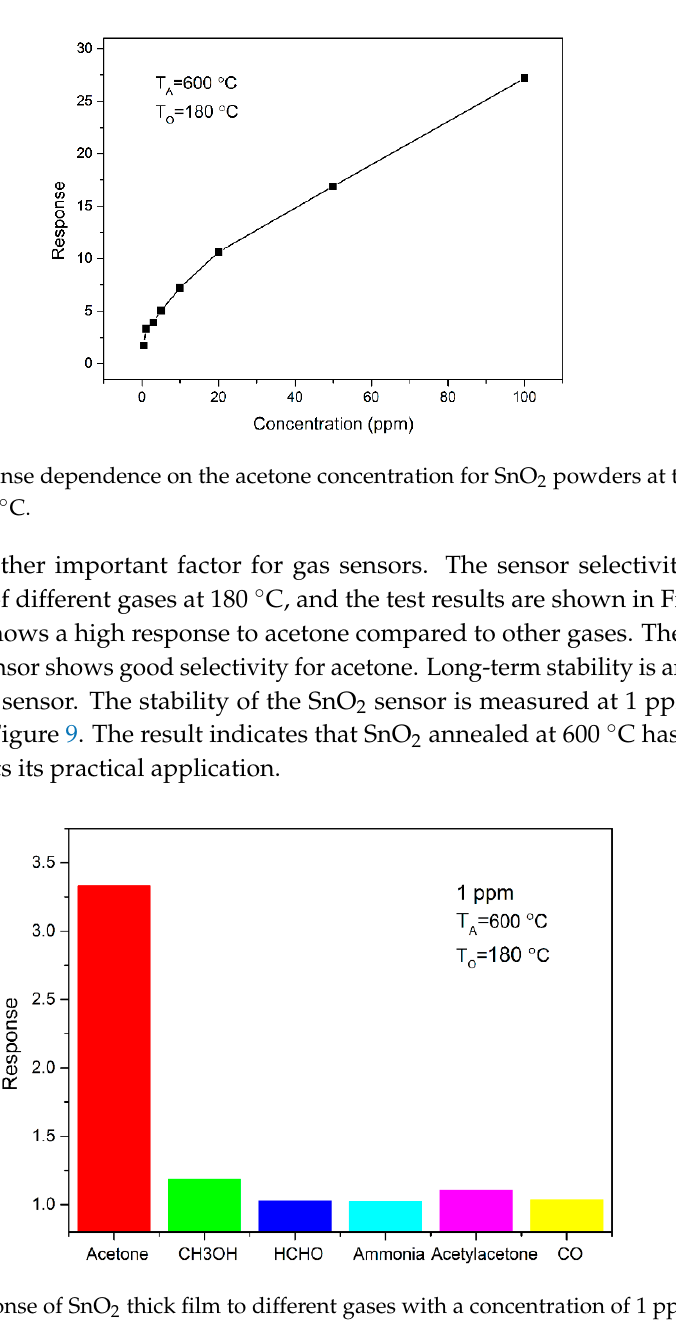
Figure 9. Response stability of SnO 2 thick film sensor measured upon exposure to 1 ppm acetone gas for 33 days.